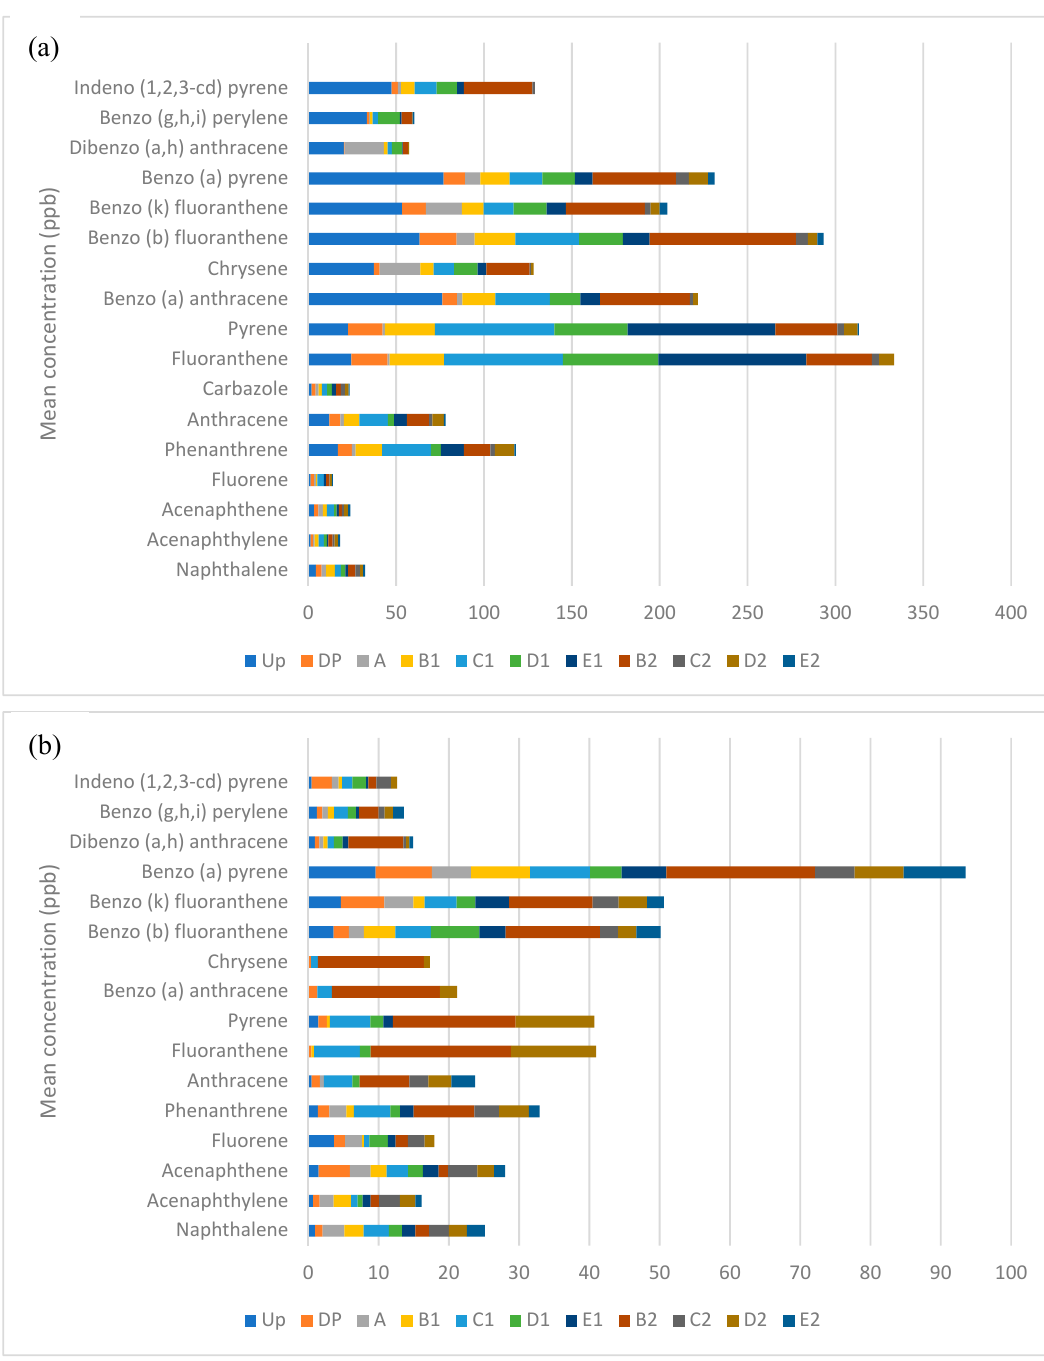
Figure 9. ( a , b ): PAH detected in the dry and wet season respectively along the Johan River. In the dry season, mean concentration of most PAHs in station upstream, discharge point, A, B1, C1, D1, E1, B2, C2, D2, and E2 was 29.2 ppb, 7.5 ppb, 6.2 ppb, 10.8 ppb, 19.4 ppb, 13.9 ppb, 14.8 ppb, 24.2 ppb, 2.4 ppb, 4 ppb, and 1.1 ppb, respectively, and for the wet season were 1.8 ppb, 2 ppb, 1.6 ppb, 1.6 ppb, 3.3 ppb, 1.9 ppb, 1.5 ppb, 8.8 ppb, 2.1 ppb, 3.6 ppb, and 1.7 ppb. The concentration of